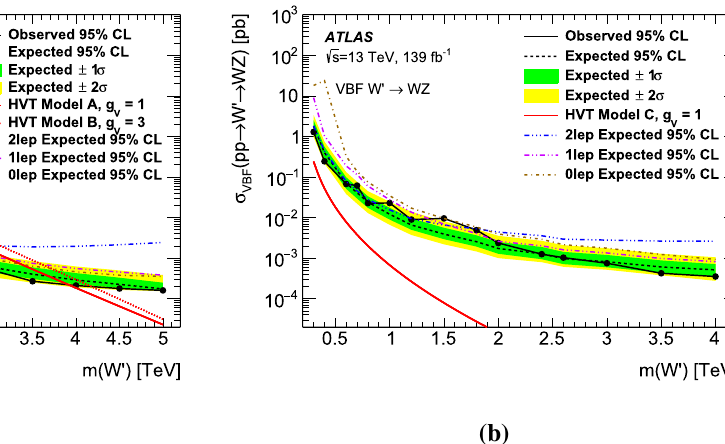
Fig. 13 Observed (black solid curve) and expected (black dashed shown for comparison. Limits are calculated in the asymptotic approx- imation below 3 (1) TeV and are obtained from pseudo-experiments curve) 95% CL upper limits on the a DY and b VBF production cross- √ s = 13 TeV in the W Z decay mode as above that for DY (VBF) production. Theoretical predictions as func- section of an HVT W (cid:4) boson at tions of the W (cid:4) boson mass are overlaid in a for Model A (red solid functionsofitsmass,combiningsearchesinthethreeleptonicchannels. The green (inner) and yellow (outer) bands represent ± 1 σ and ± 2 σ curve) and Model B (red dotted curve) and in b for Model C (red solid uncertainty in the expected limits. Limits expected from individual lep- curve) tonic channels (dot-dashed curves inblue, magenta, and brown) are also